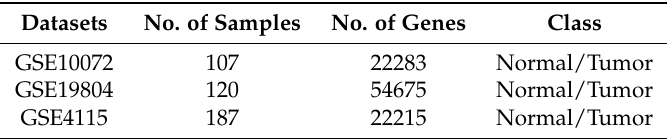
Table 1. Three publicly available cancer datasets used in the experiments